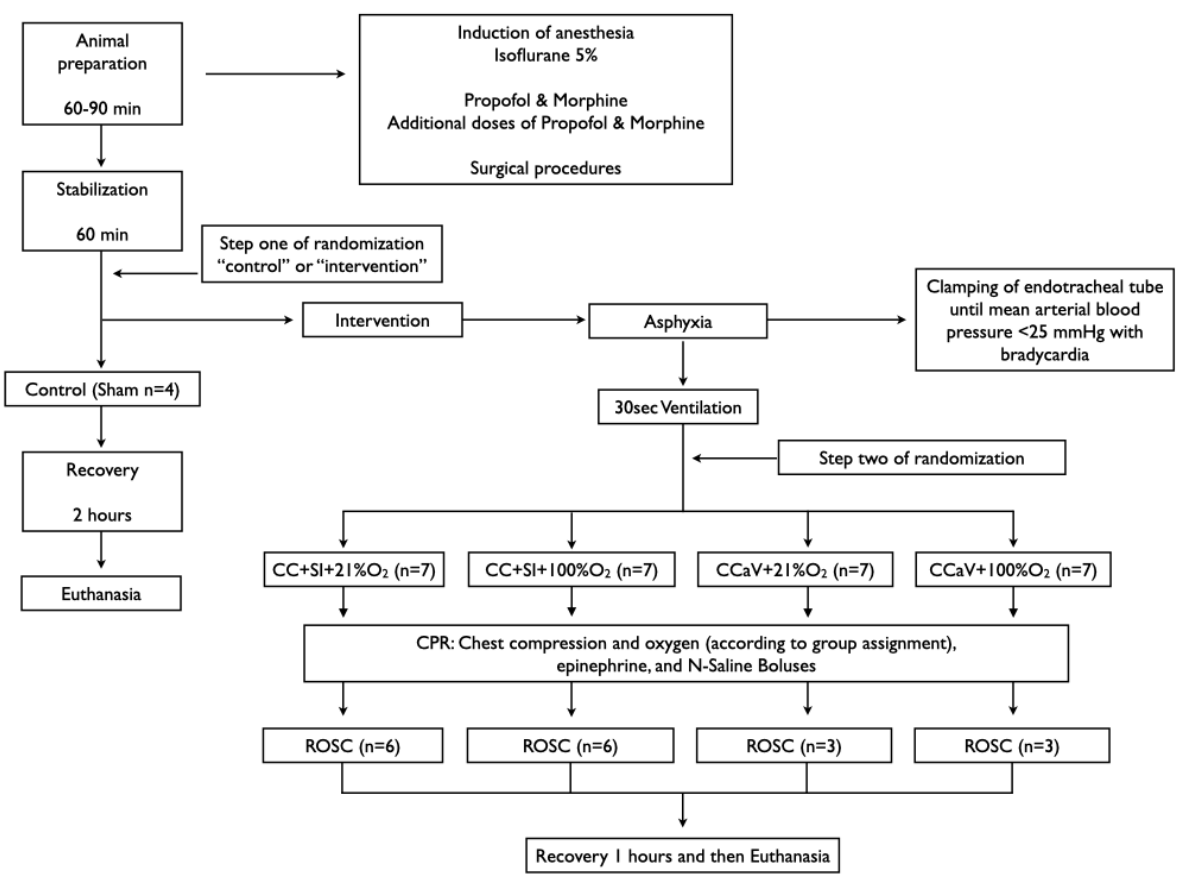
Figure 1. Study flow chart.